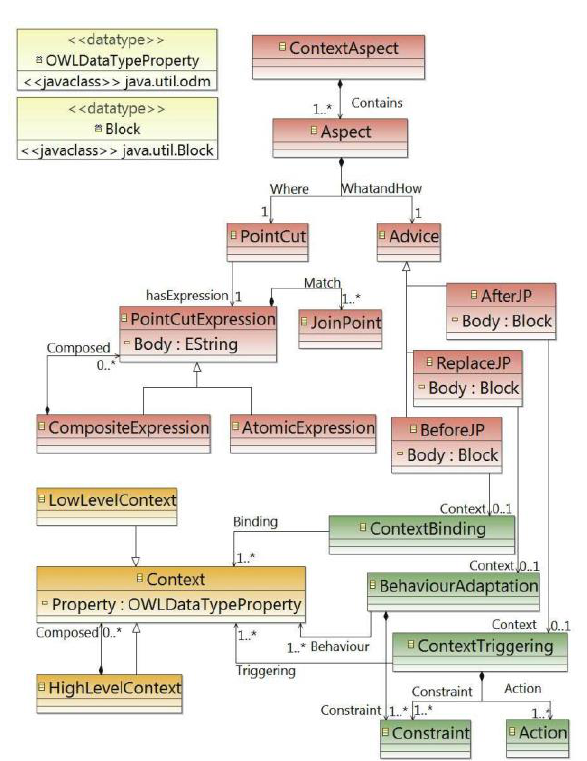
Figure 1. ContextAspect MetaModel